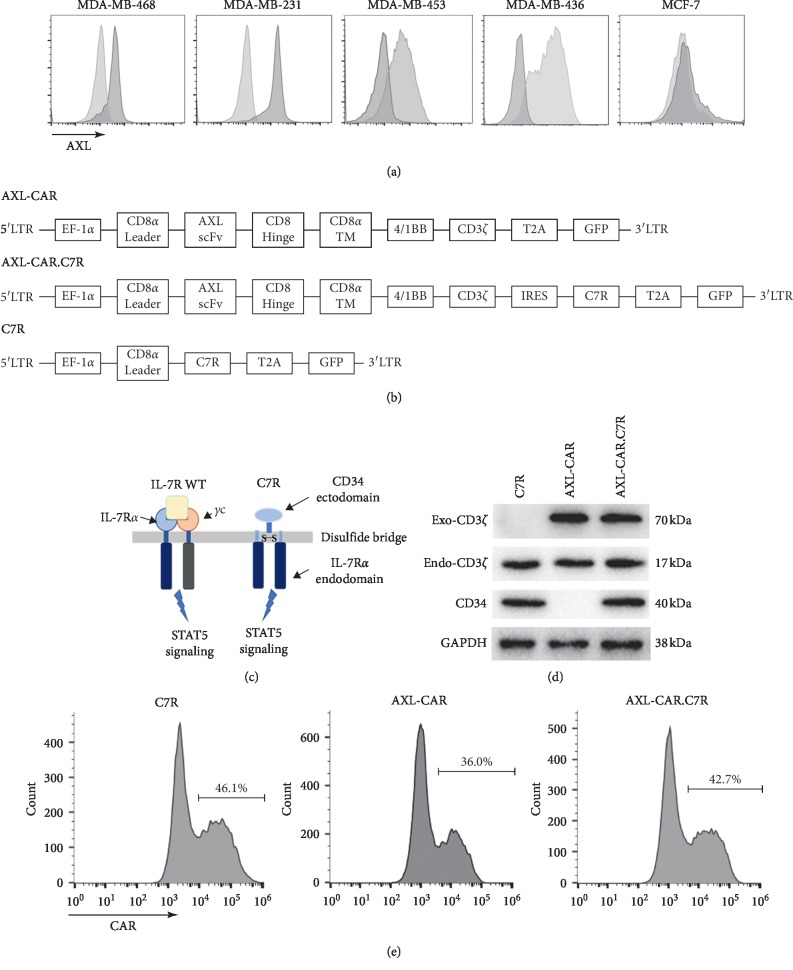
Screening of target cells and the construction of engineered T cells. (a) The expression levels of AXL in target cells detected by flow cytometry. (b) Schematic diagram of C7R, AXL-CAR, and AXL-CAR.C7R. (c) Working principle diagram of C7R. (d) CD3ζ and CD34 were detected by immunoblot assay. Exogenous CD3ζ was presented at 70 kDa only in the lanes of CAR-T cells, and endogenous CD3ζ was presented at 17 kDa in the lanes of control T cells and CAR-T cells. CD34 is presented in cells containing C7R. GAPDH is used as an internal standard. (e) The transfection efficiency of engineered T cells was determined by GFP expression in T cells using flow cytometry.